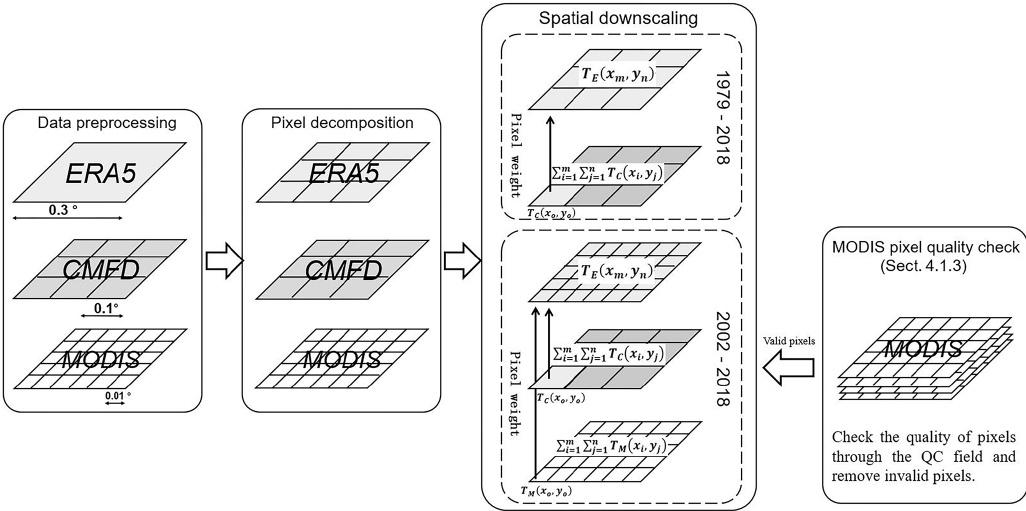
Figure 4. Flowchart for spatial downscaling, where nv represents the number of valid